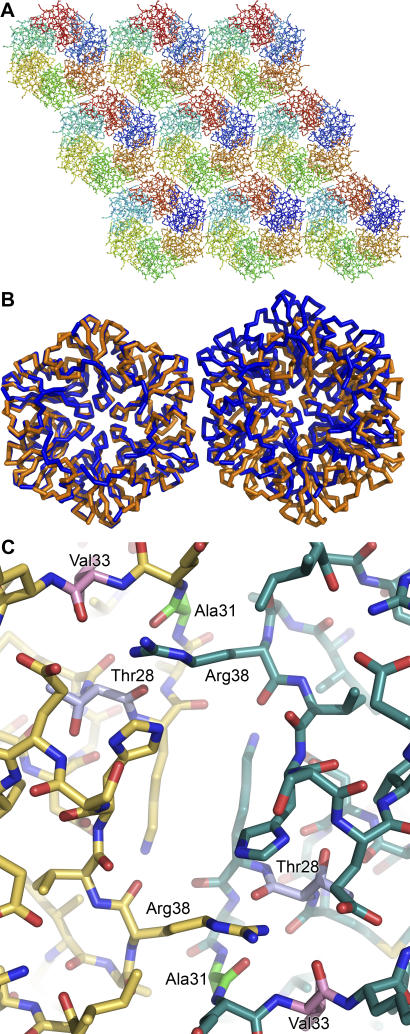
Packing of CsoS1A Hexamers in a Layer(A) Individual CsoS1A molecules are colored differently in each hexamer. CsoS1A molecules in the same hexameric position are colored the same.(B) Backbone alignment of adjacent CsoS1A hexamers and adjacent CcmK2 hexamers [7] from the beta-type cyanobacterial carboxysome shell. CsoS1A is indicated in blue, and CcmK2 is shown in orange. The shift between adjacent hexamers in CsoS1A compared to CcmK2 leads to the tighter packing.(C) A close-up view of the interaction between two adjacent CsoS1A hexamers. The two hexamers are colored separately in yellow and gray. Arg83 from each hexamer is shown surrounded by residues belonging to the adjacent hexamer: Val33 (pink), Ala31 (green), and Thr28 (light blue).